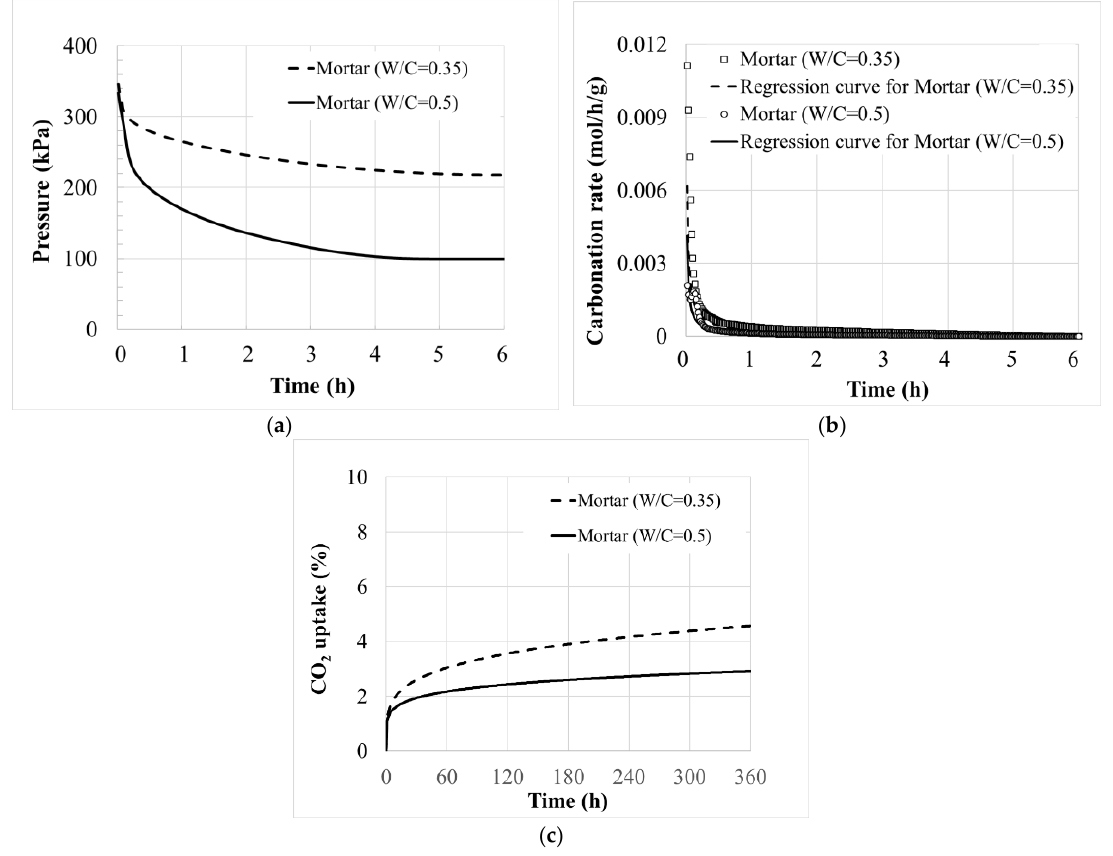
Figure 2. Pressure loss and CO 2 uptake of Mortar (W/C = 0.35) and Mortar (W/C = 0.5). ( a ) Decrease of CO 2 pressure, ( b ) Carbonation rate, ( c ) CO 2 uptake. CO 2 pressure, ( b ) Carbonation rate, ( c ) CO 2